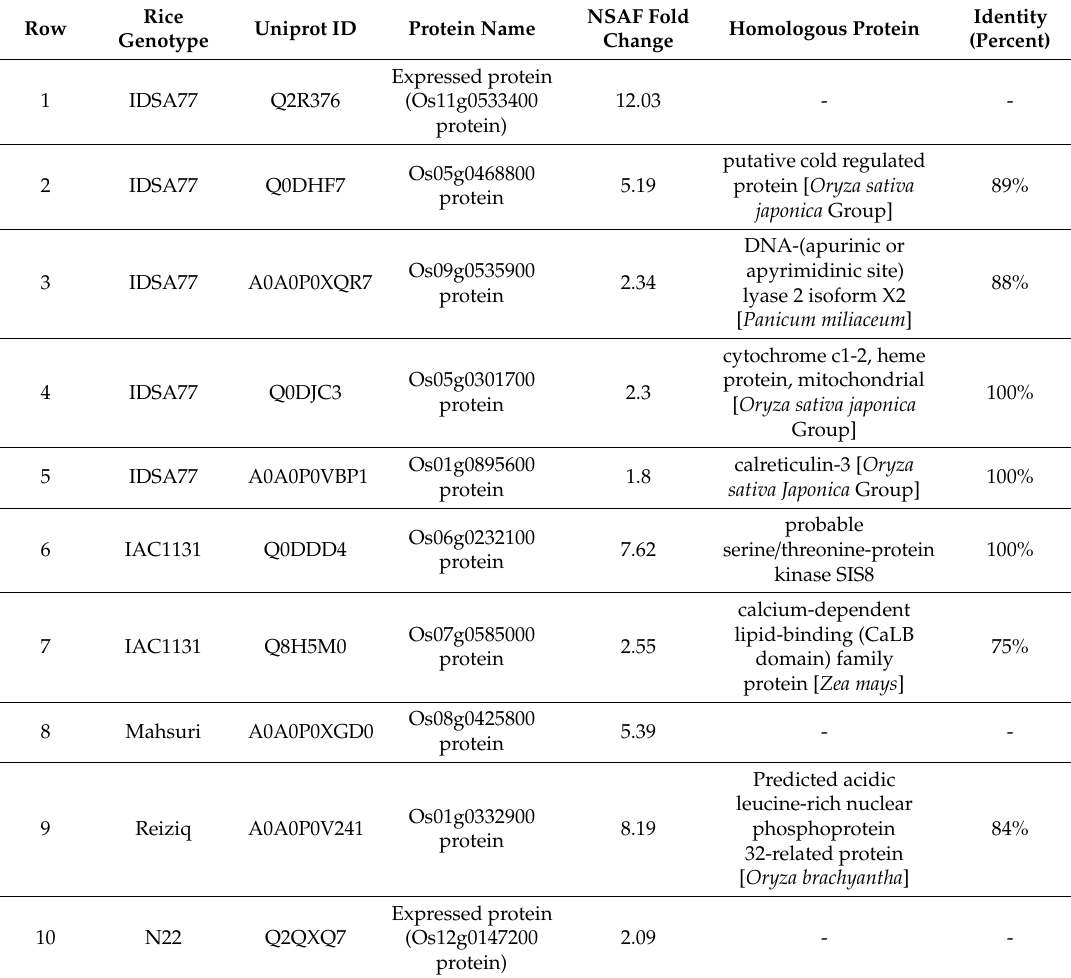
Table 2. Proteins with uncharacterized or predicted function, which increased in abundance in response to drought stress in only one rice